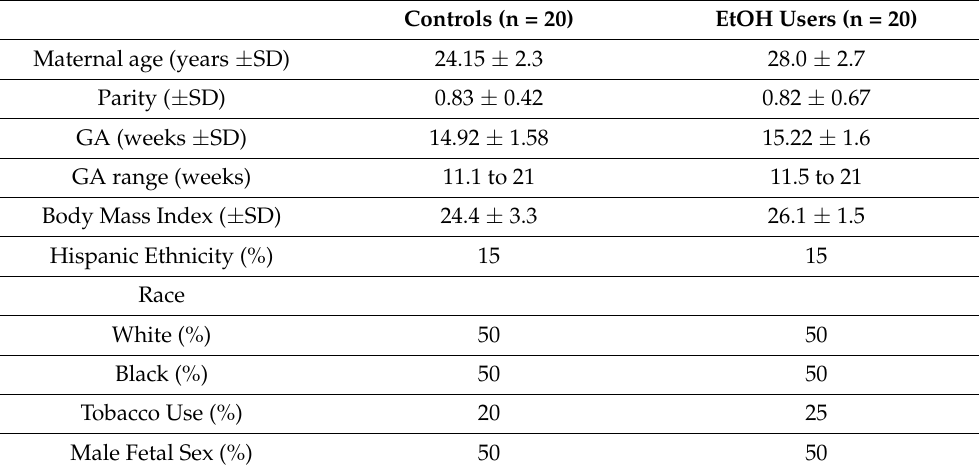
Table 2. Clinical characteristics of pregnant subjects used in most of the experiments.